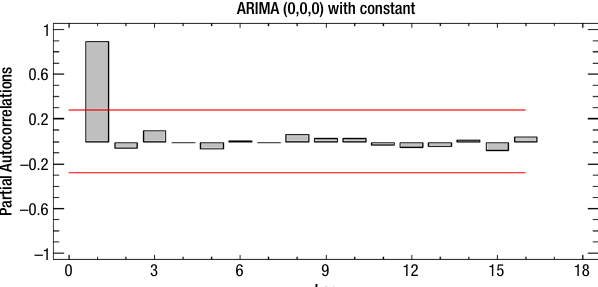
Fig. 13b. Residual partial autocorrelations for time series of annual Argentinian GDP